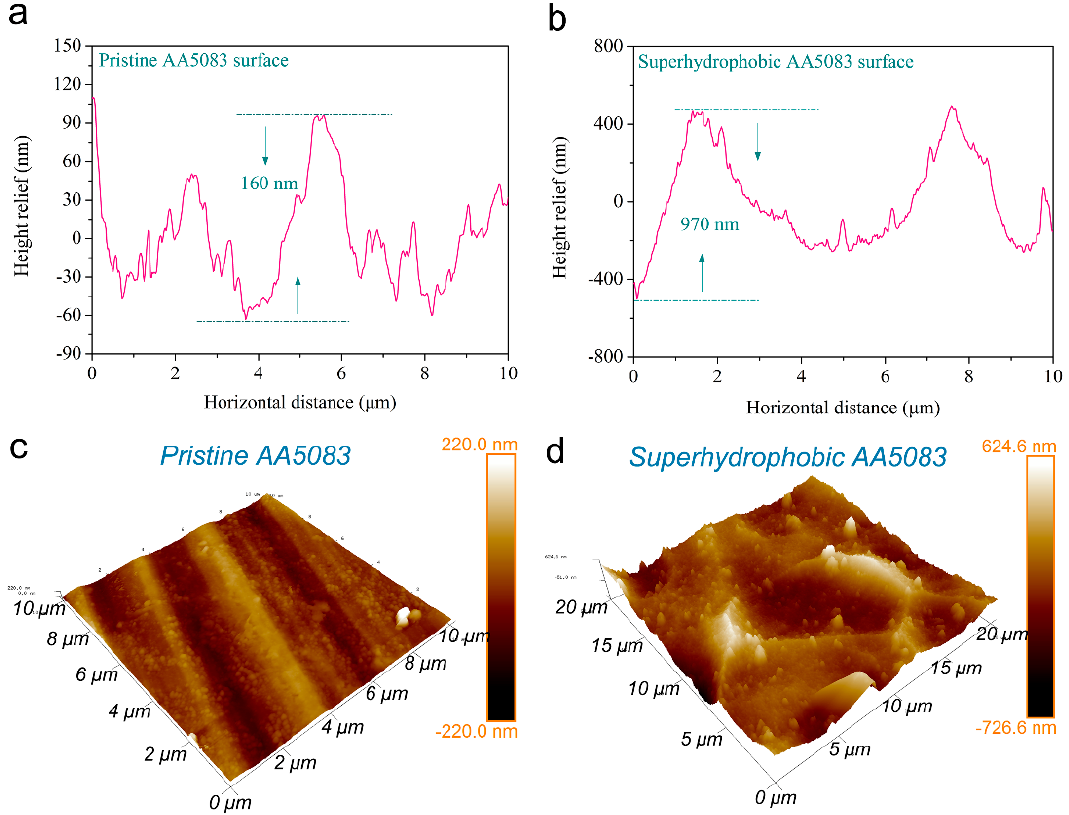
Figure 3. Surface relief and 3D atomic force microscopy (AFM) images of pristine AA5083 ( a , c ) and superhydrophobic AA5083 ( b , d ).